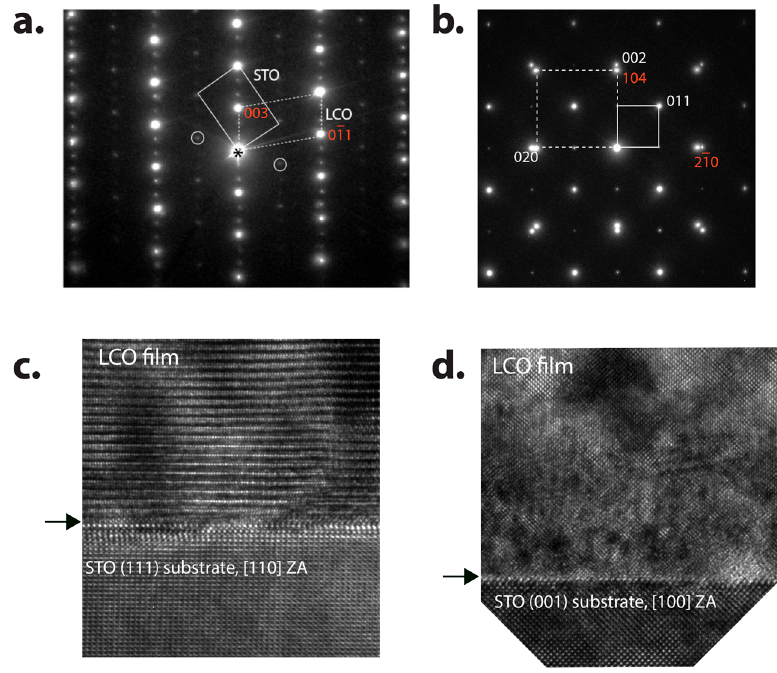
Figure 4. Selected area electron diffraction (SAED) patterns and high-resolution transmission electron microscopy (TEM) from cross-sectioned samples of LiCoO 2 films deposited on (111) ( a , c ) and (100) ( b , d ) surfaces of SrTiO 3 (STO) showing epitaxial nature of the films. For SAED patterns, the cells of STO (continuous line, indexes in white) and LiCoO 2 (LCO) (dashed line, indexes in red) are shown; LCO/STO interfaces are indicated with arrows on the high-resolution images (Images are taken from our previously published work, see Ref. [14]).